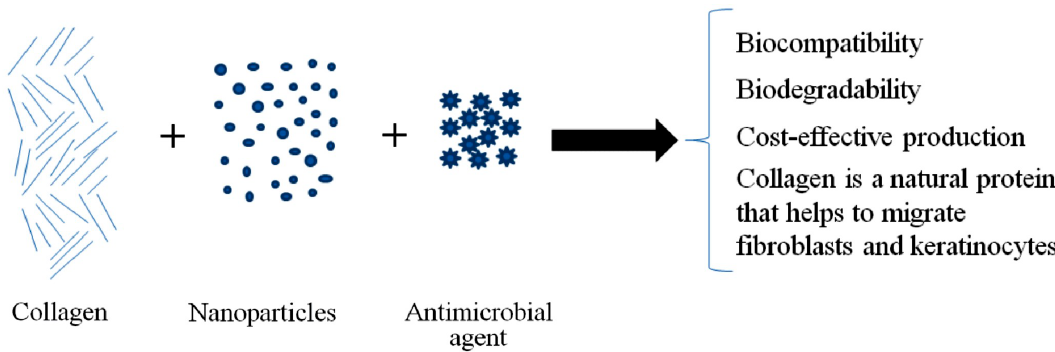
Figure 1. The main advantages of the functionalized collagen hydrogels.